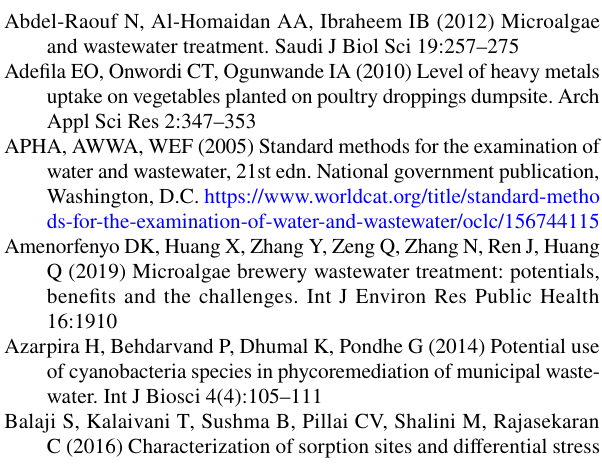
Fig. 10 Morphological appearance of Chlorella sp. on fluorescent microscope—nile red staining a white light and b UV